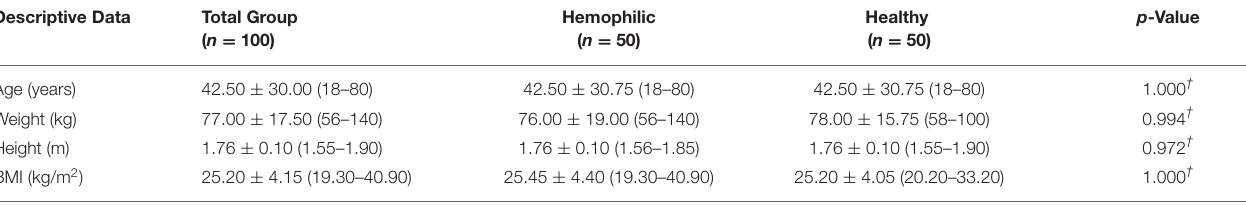
TABLE 1 | Descriptive data of the patients with hemophilia and healthy matched-paired controls. Descriptive Data